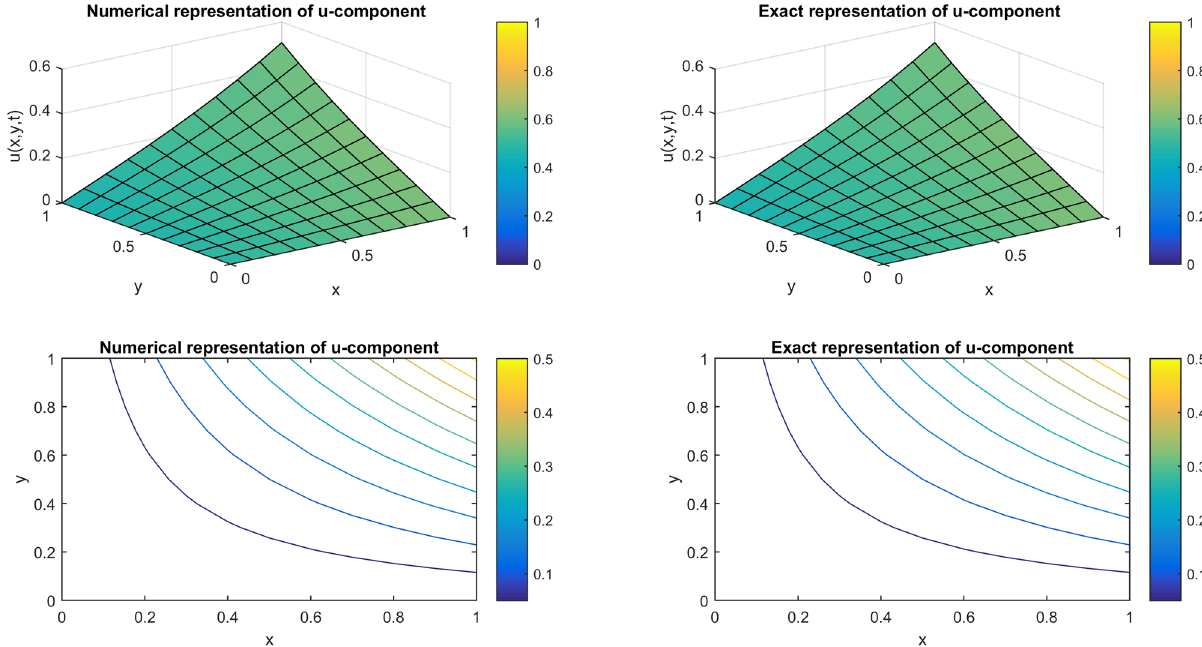
Figure 12: Surface and contour plots for u component at t = 1 for = N 11 , = α 10 , = β 5 , = t Δ 0.0001 , and = τ 0.5 using Method II regarding Example